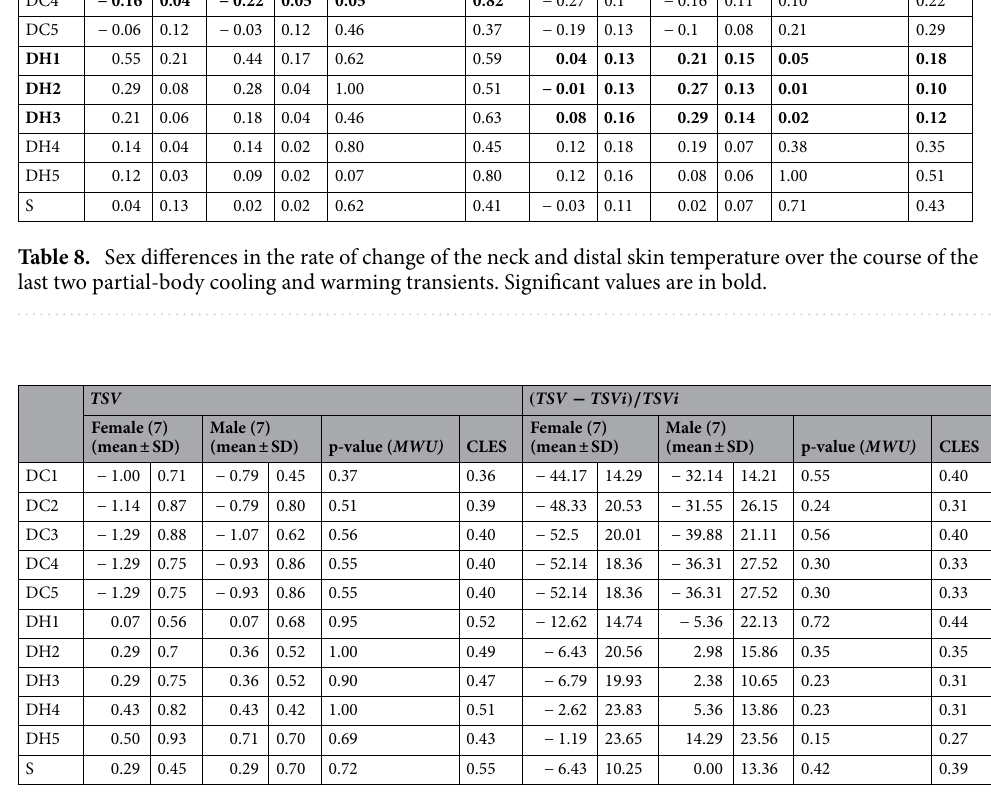
Table 9. Sex differences in thermal sensation vote and its relative change over the course of the last two partial-body cooling and warming